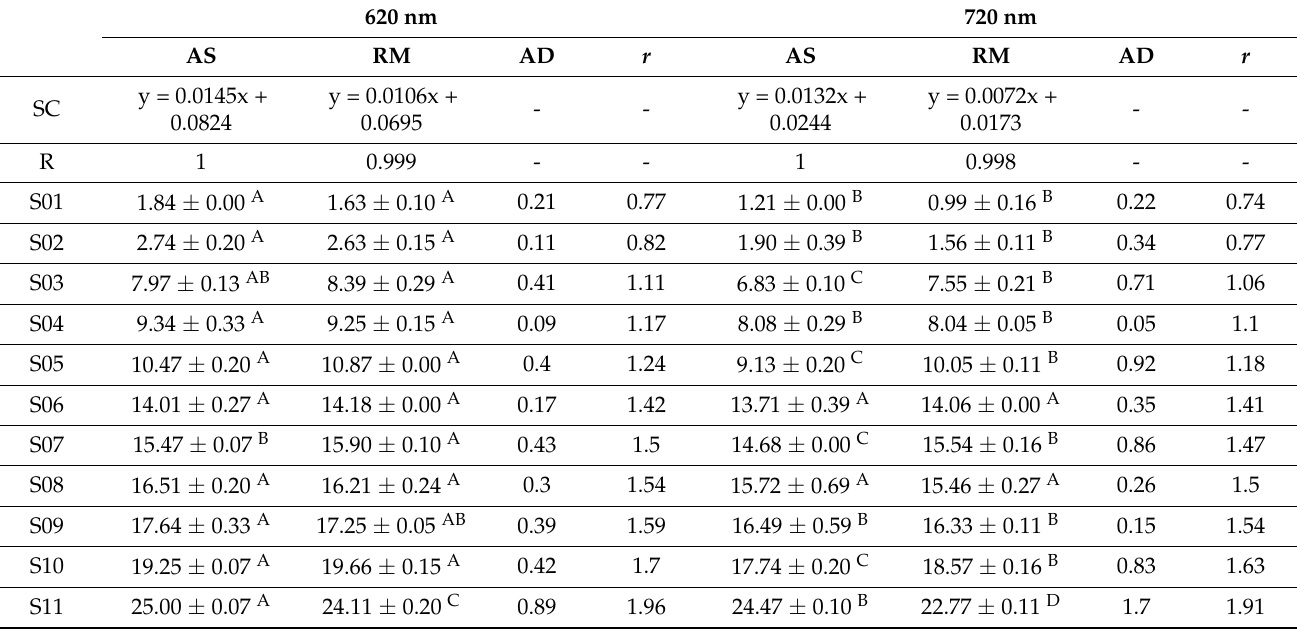
Table 6. The application of the reference materials in detecting AAC of rice samples a . 620 nm 720